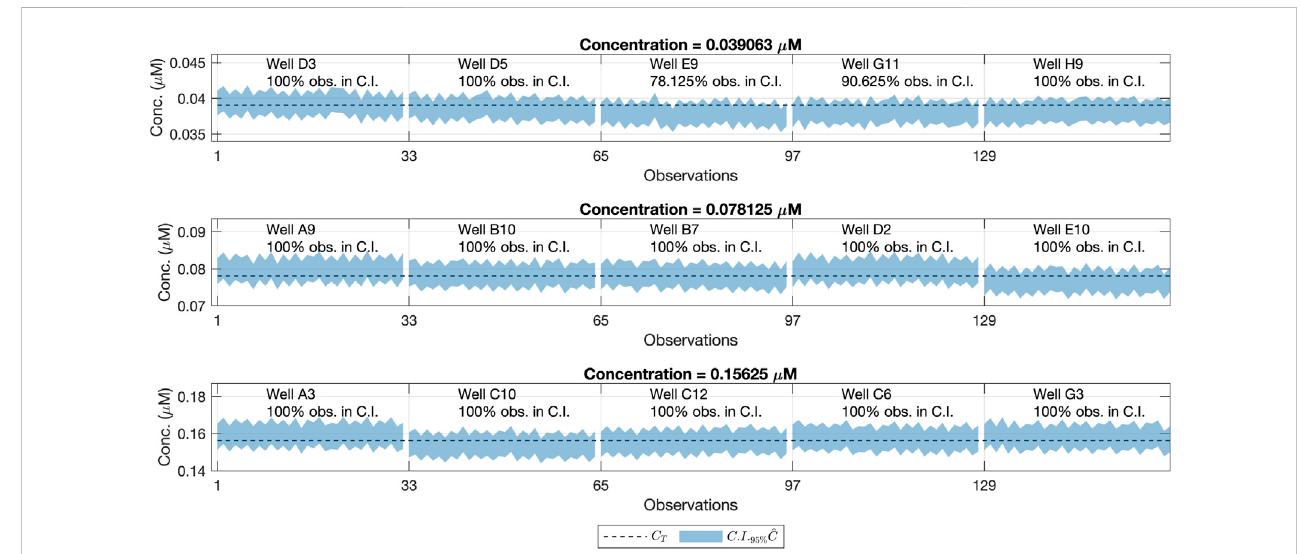
FIGURE 6 Con fi dence Intervals (95%) for the concentration values (shaded area) and reference concentration values (dashed line). Each row refers to one concentration level, the same ones as in the Model Building step, measured also at the same gains but from different wells. Each column corresponds to a different well and its location on the 96-well plate. For each well, we had a total of 32 (8 repetitions × 4 gains) predictions of ^ C .